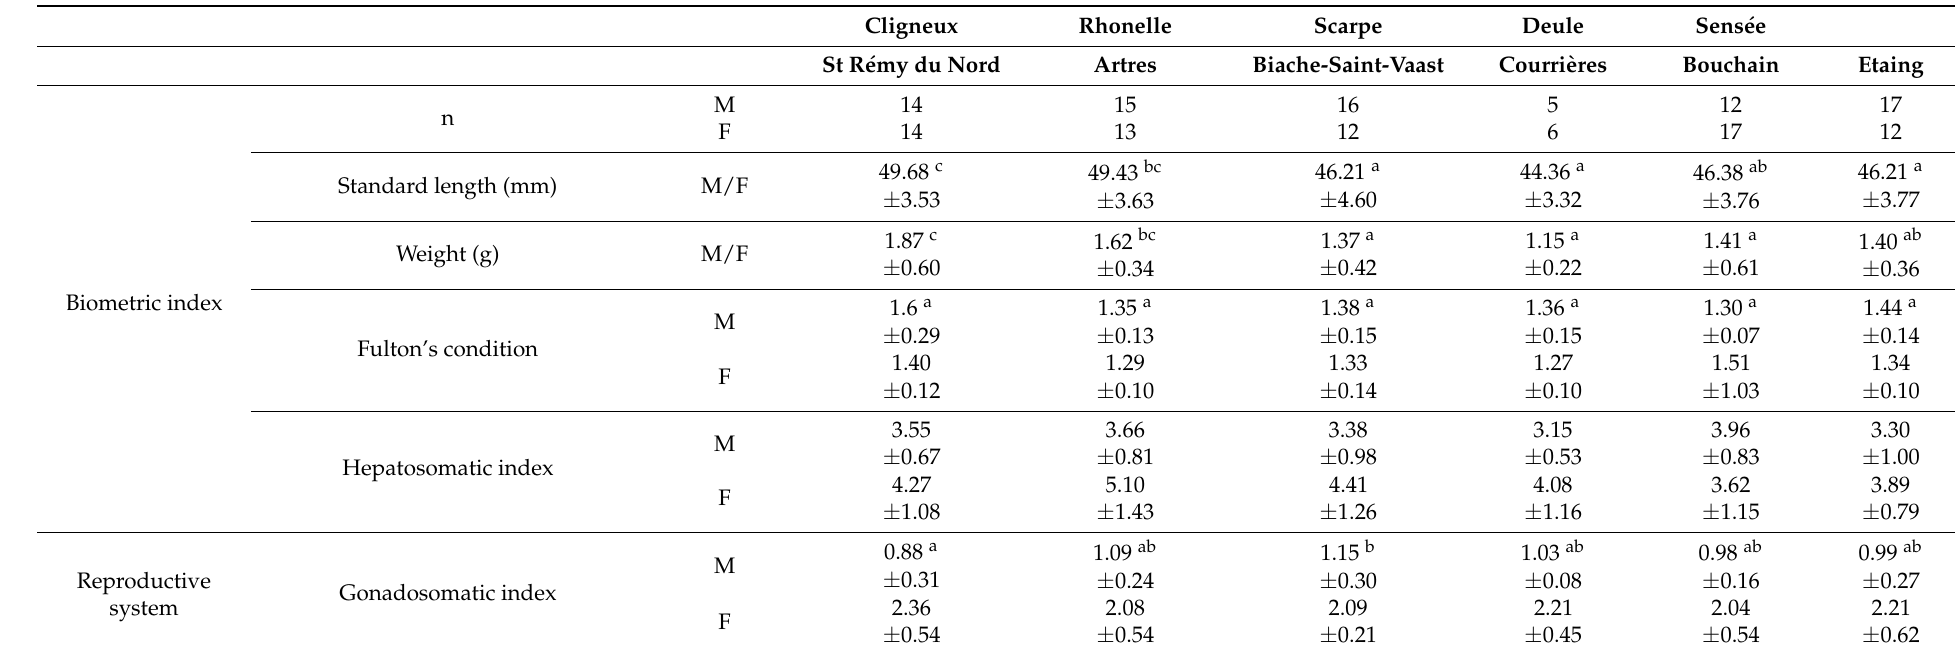
Table 2. Biomarker responses assessed in sticklebacks after 21 day of caging in the six sites studied. Data are expressed as means ± standard deviation and letters represent differences between sites ( p ≤ 0.05) according to a Tukey test or Nemenyi test. n: number of fish dissected for each site; Che: Cholinesterase;